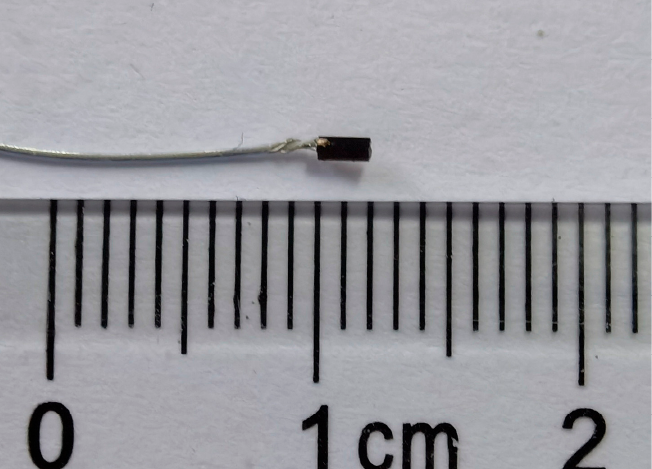
Figure 2. The fabricated micro high-frequency transducer.